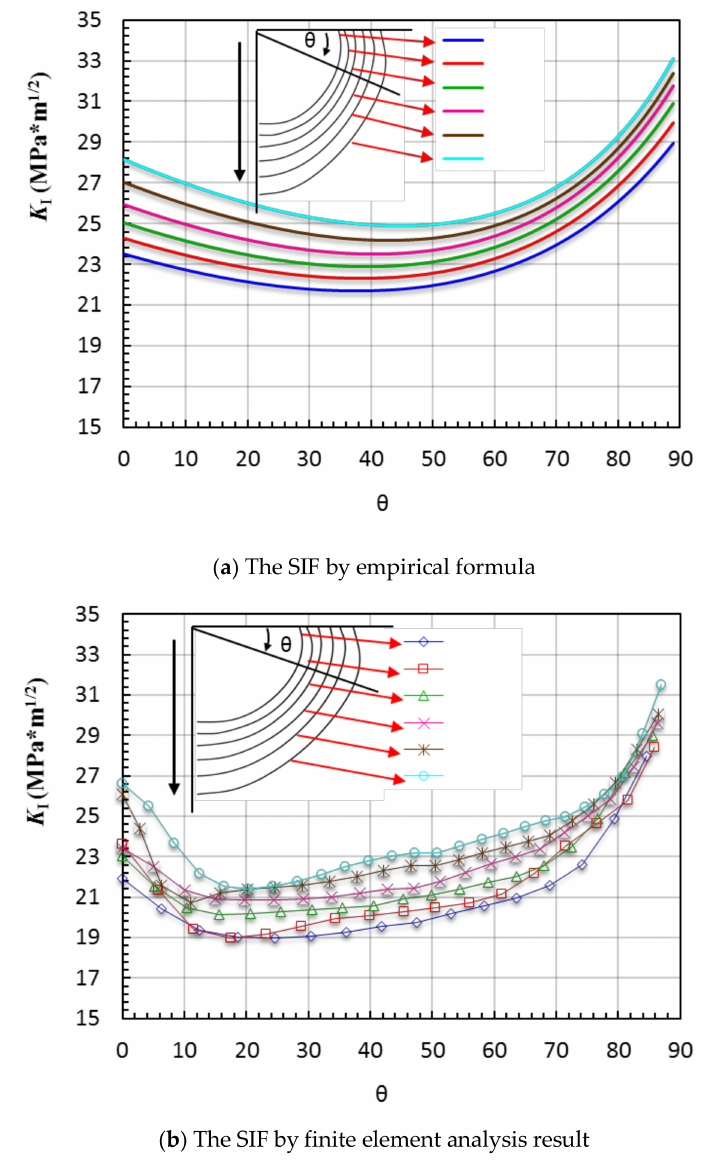
Figure 18. Stress intensity factor comparison between empirical formula and finite element analysis result in the first stage of crack growth. (The di ff erent color lines represent di ff erent crack front.).